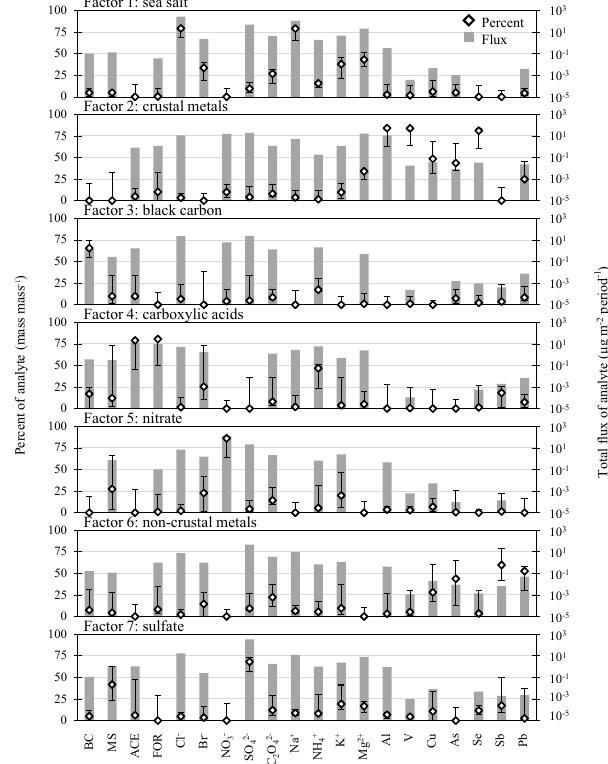
Figure 1. Factor profiles. The loading of each analyte to each factor is provided as the portion of their flux apportioned to that factor as well as the percentage of the analyte’s total flux (mass / mass) ap- portioned to that factor. Error bars on the percentage loading show the 25th and 75th percentiles of the bootstrapping analysis. Flux contributions below 0.00001µgm − 2 period − 1 are not shown. Met- als with a charge are those measured by IC; others are insoluble portions measured by